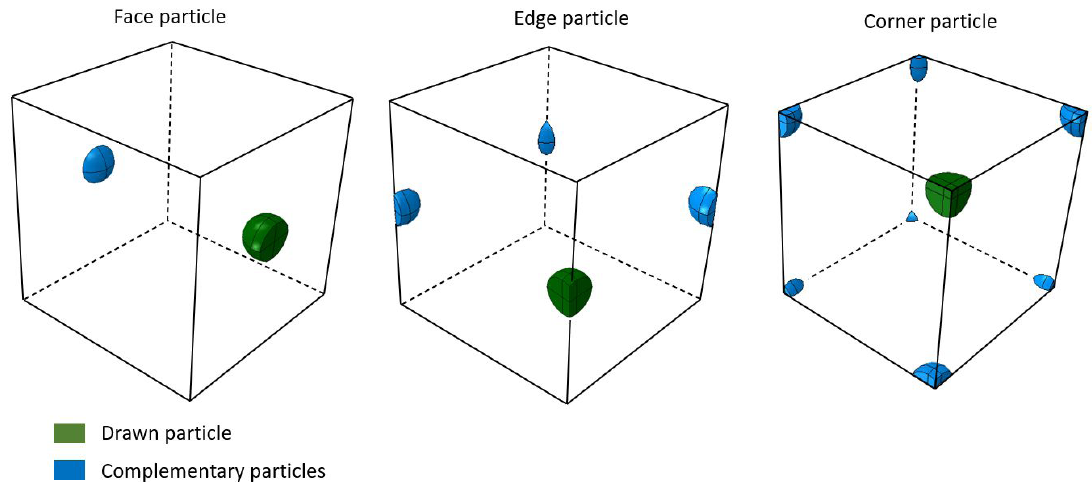
Figure 6. Replication of the inclusions depending on the number of intercepted